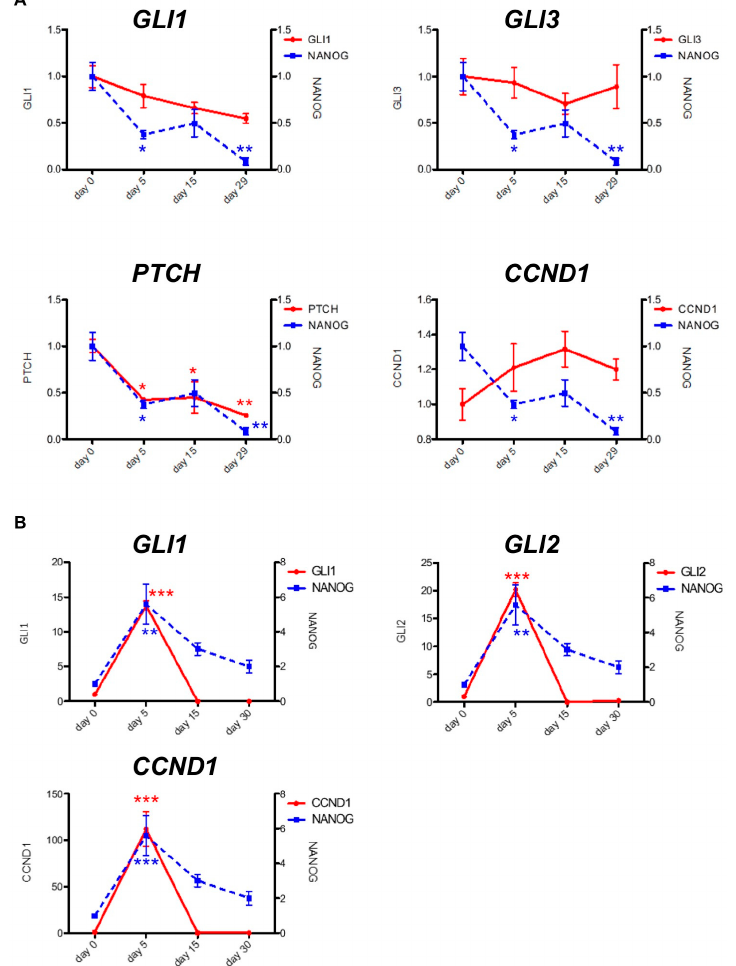
Figure 2. Changes in NANOG transcript levels were coincident with GLI-target genes. Transitions in NANOG and GLI-target gene transcript levels were associated together in ( A ) one AML patient under clinical PF-913 monotherapy, as well as in ( B ) another AML patient. Data are expressed as the mean ± SEM. The significance of differences between groups was analyzed using the Bonferroni test, followed by one-way analysis of variance (ANOVA). Statistical analyses were performed with GraphPad Prism. * p < 0.05, ** p < 0.01, *** p < 0.001.